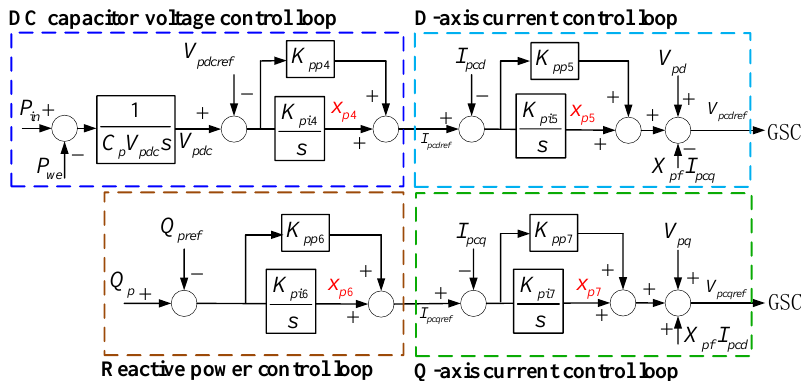
Figure 2. The control configuration of machine side converter (MSC).